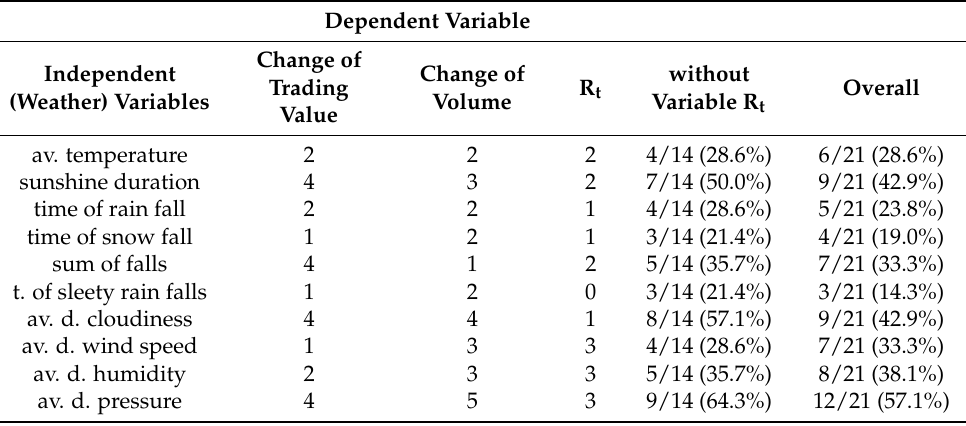
Table 4. The frequency of occurrence of a given weather factor-collective